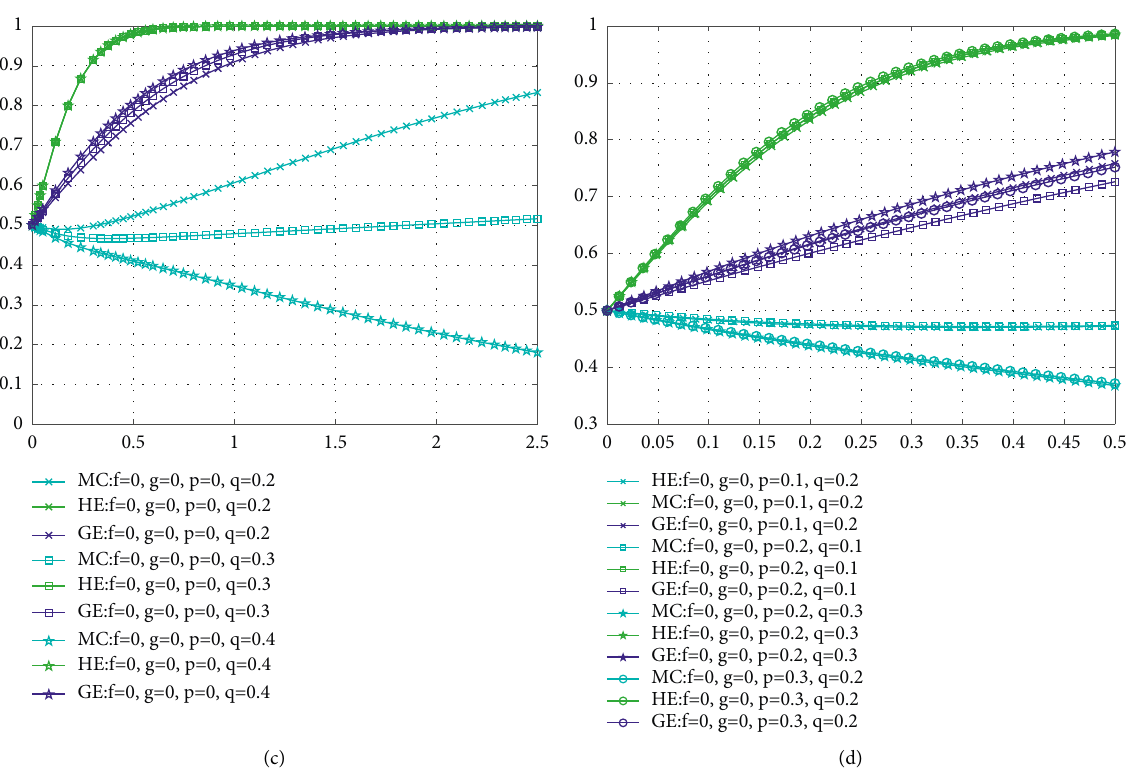
Figure 8: The evolution result of the innovation subsidy rate p, q change. (a) p, q are equal changes. (b) Only p changes. (c) Only q changes. (d) p,q are not equal